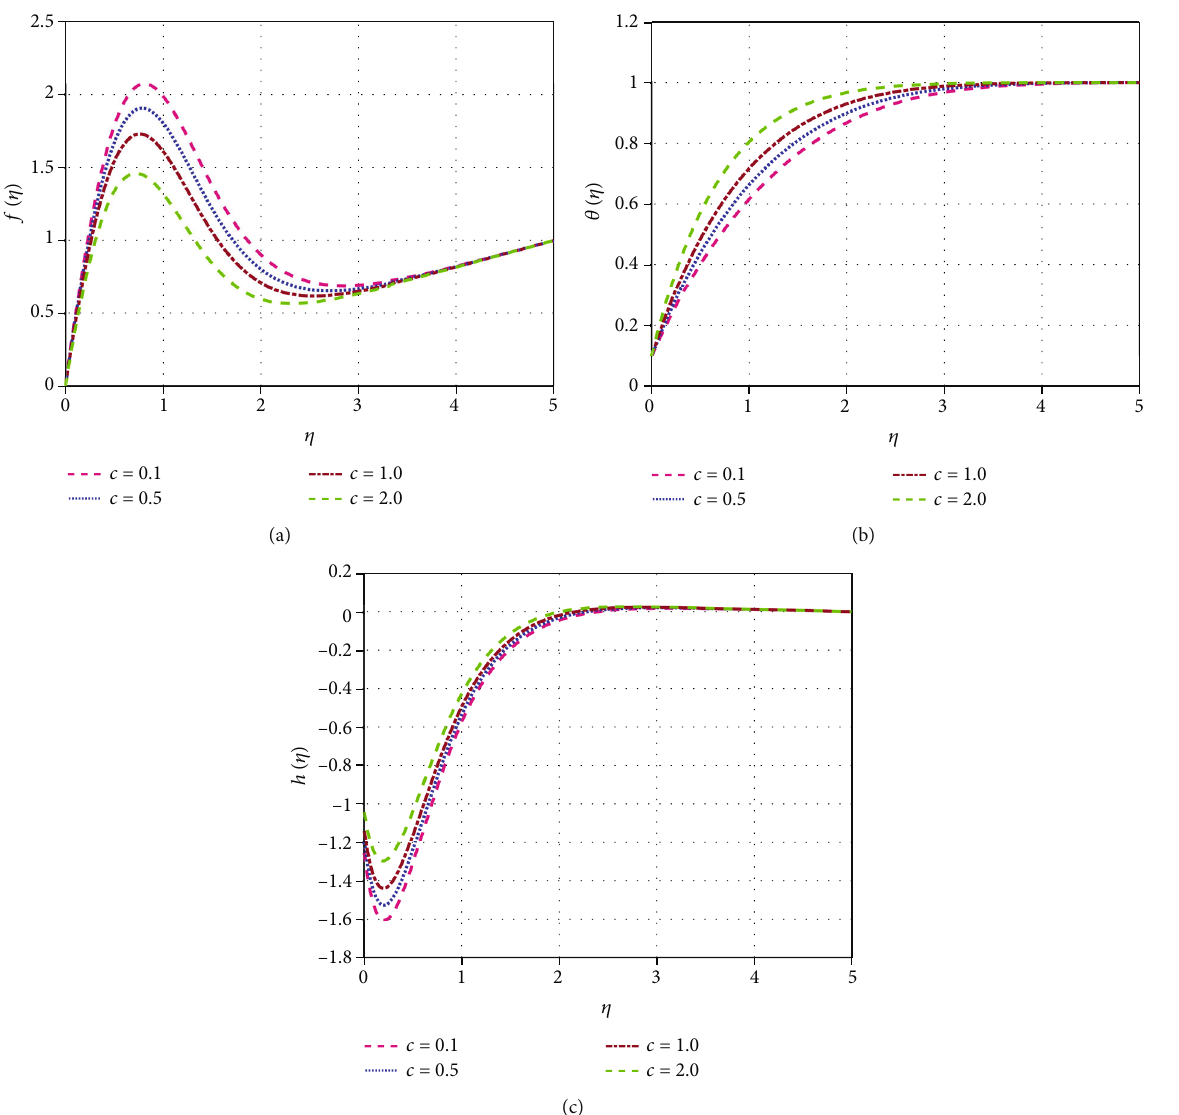
Figure 9: (a) Velocity, (b) concentration, and (c) micro-rotation pro fi les for suction variation with γ = 45 ° , M =2, R =0.5, Pr =0.71, Sc =0.22, =0.33, λ = 1, ξ =3, K =0.5, Gr =10, and Gc L 1 1